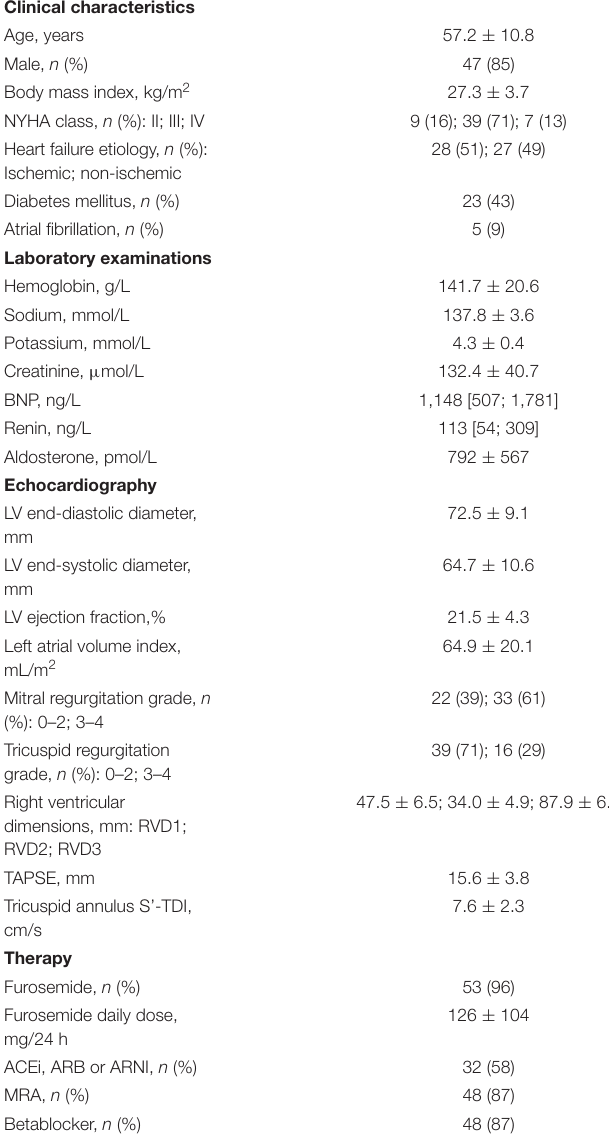
TABLE 1 | Baseline